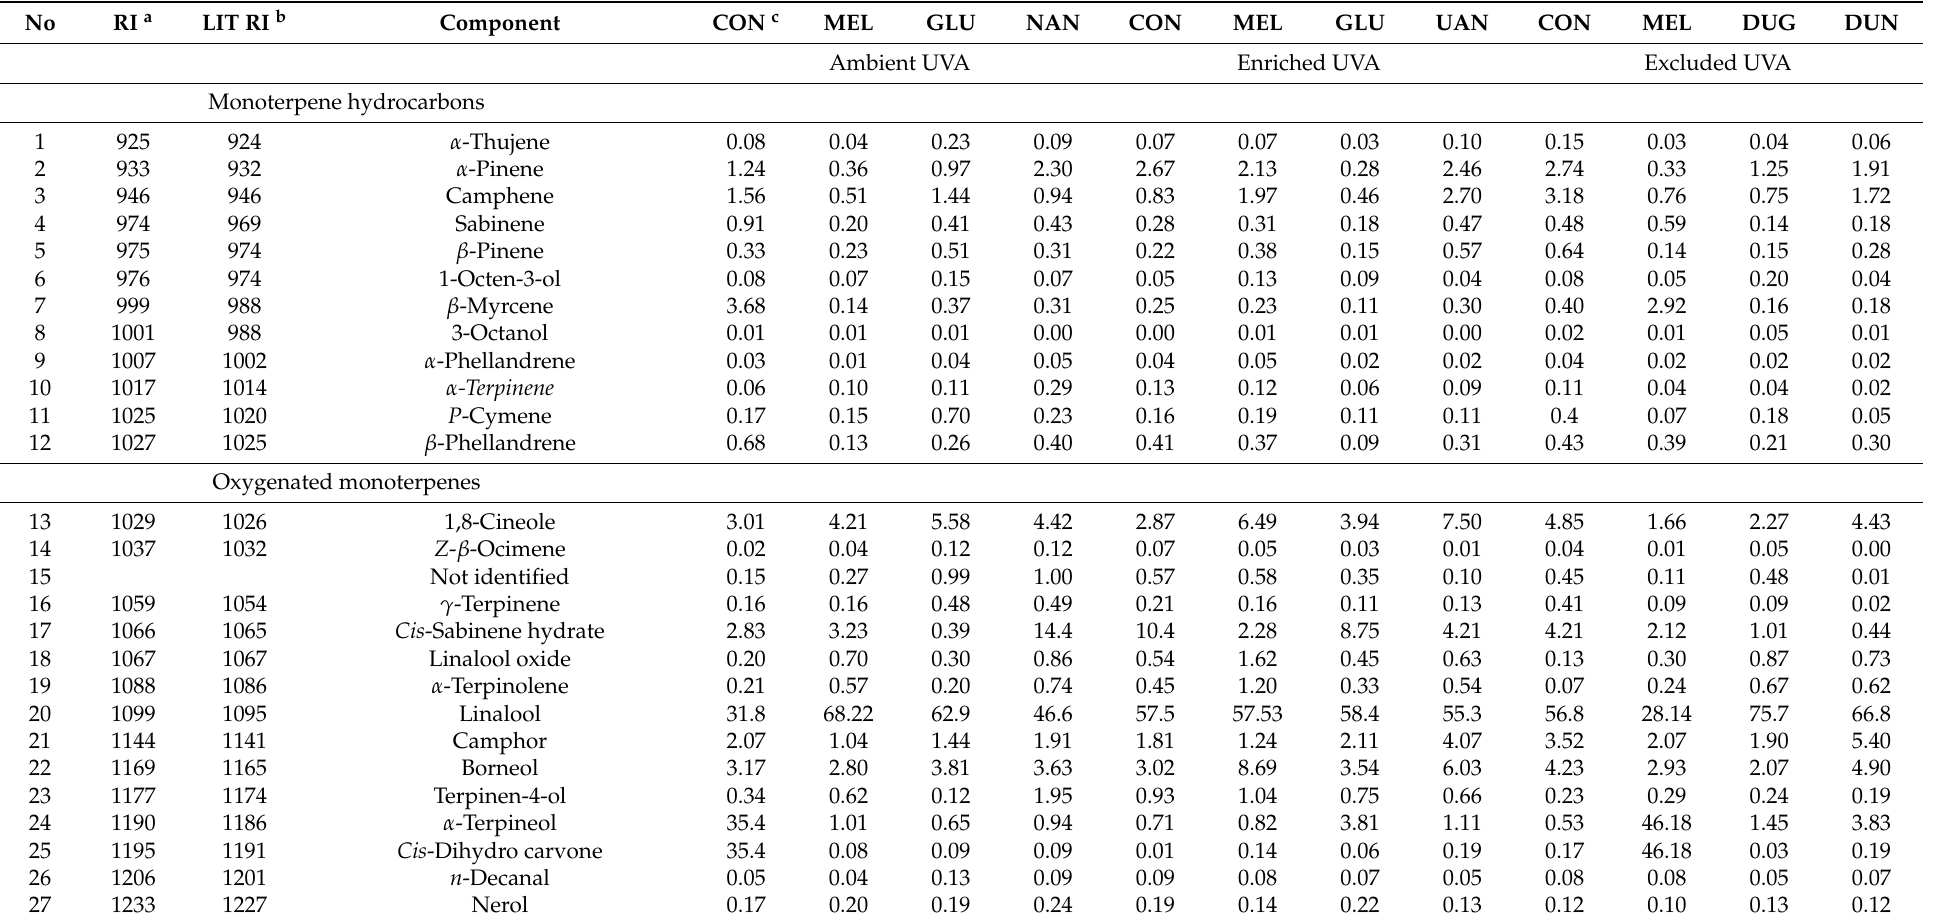
Table 5. The essential oil profile of Thymus fedtschenkoi under different UVA levels (ambient, enriched, excluded) in combination with spraying protectants